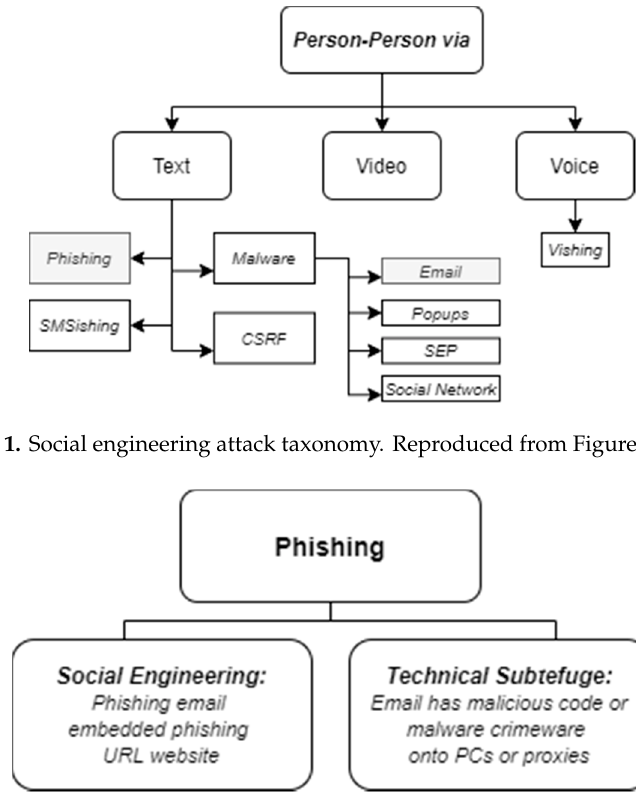
Figure 2. Phishing attack taxonomy. Reproduced from Figure 1 in [20].